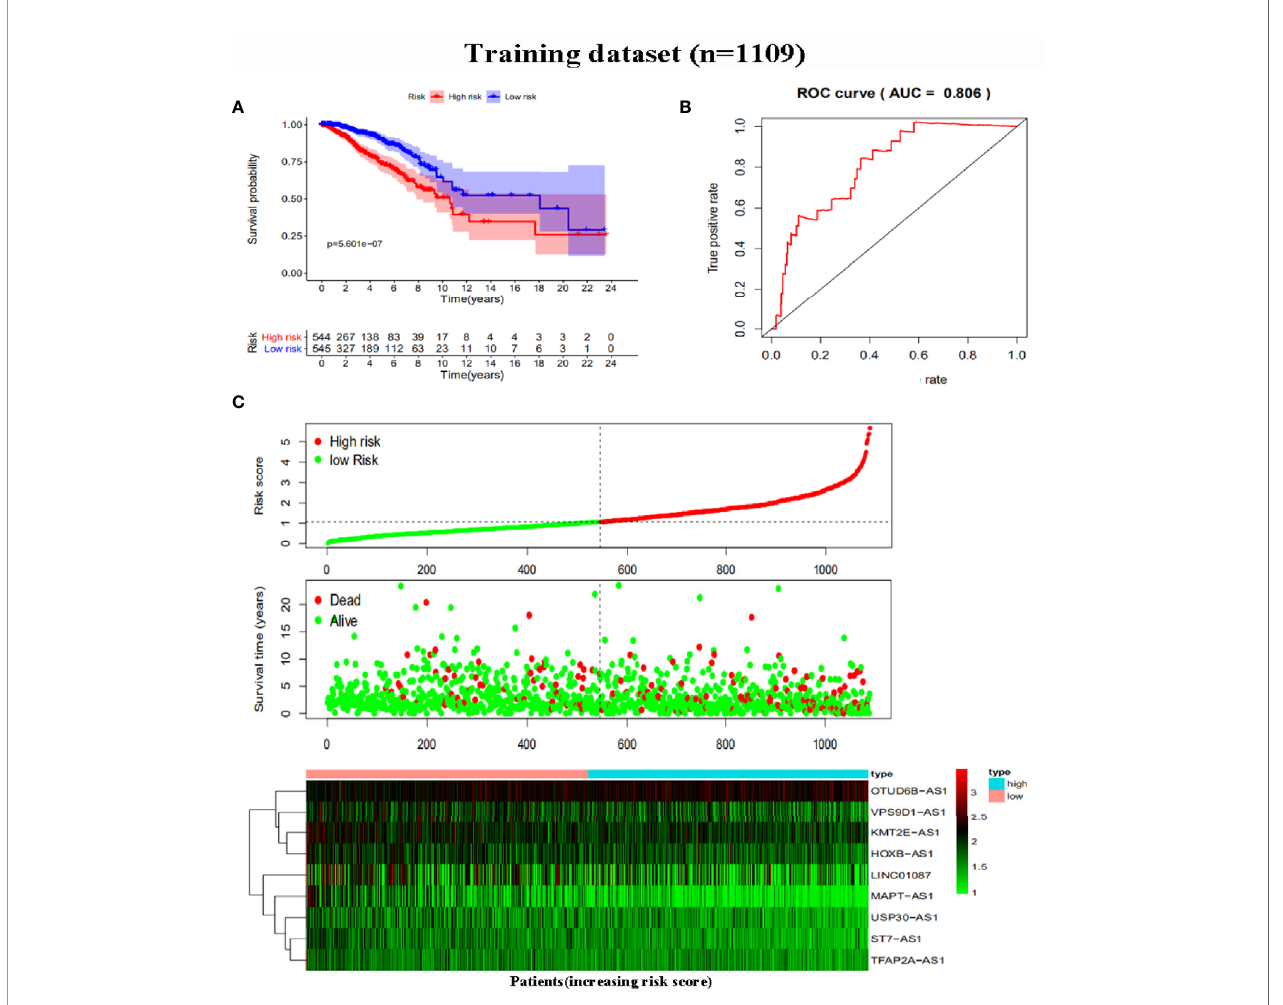
FIGURE 4 | Risk score analysis of the prognostic signature in the training dataset. (A) Kaplan-Meier survival analysis for high-risk group and low-risk group. (B) ROC curves for predicting OS based on risk score. (C) Risk score distribution, survival status, and expression heat